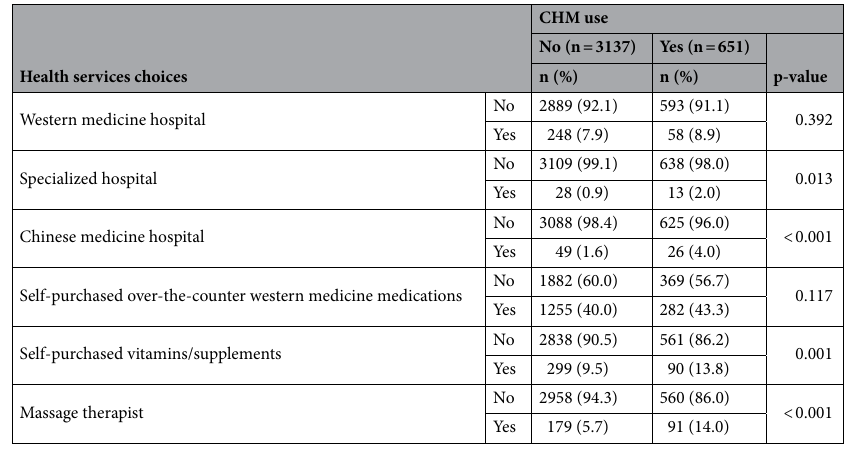
Table 3. Associations between CHM use and health services use, by Chinese women with arthritis.